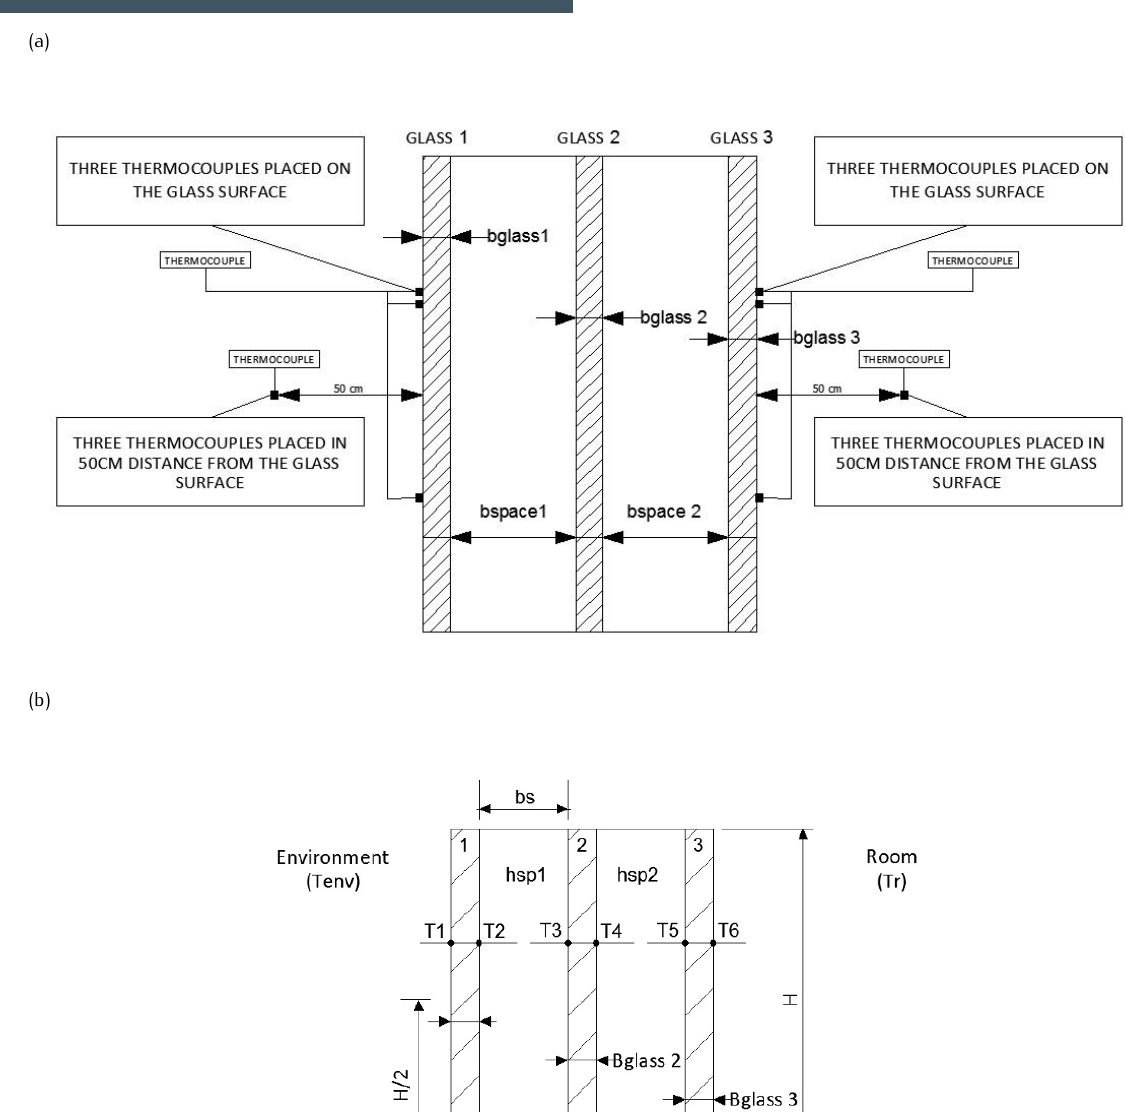
Figure 7. (a), (b) Temperatures at triple glass surfaces.